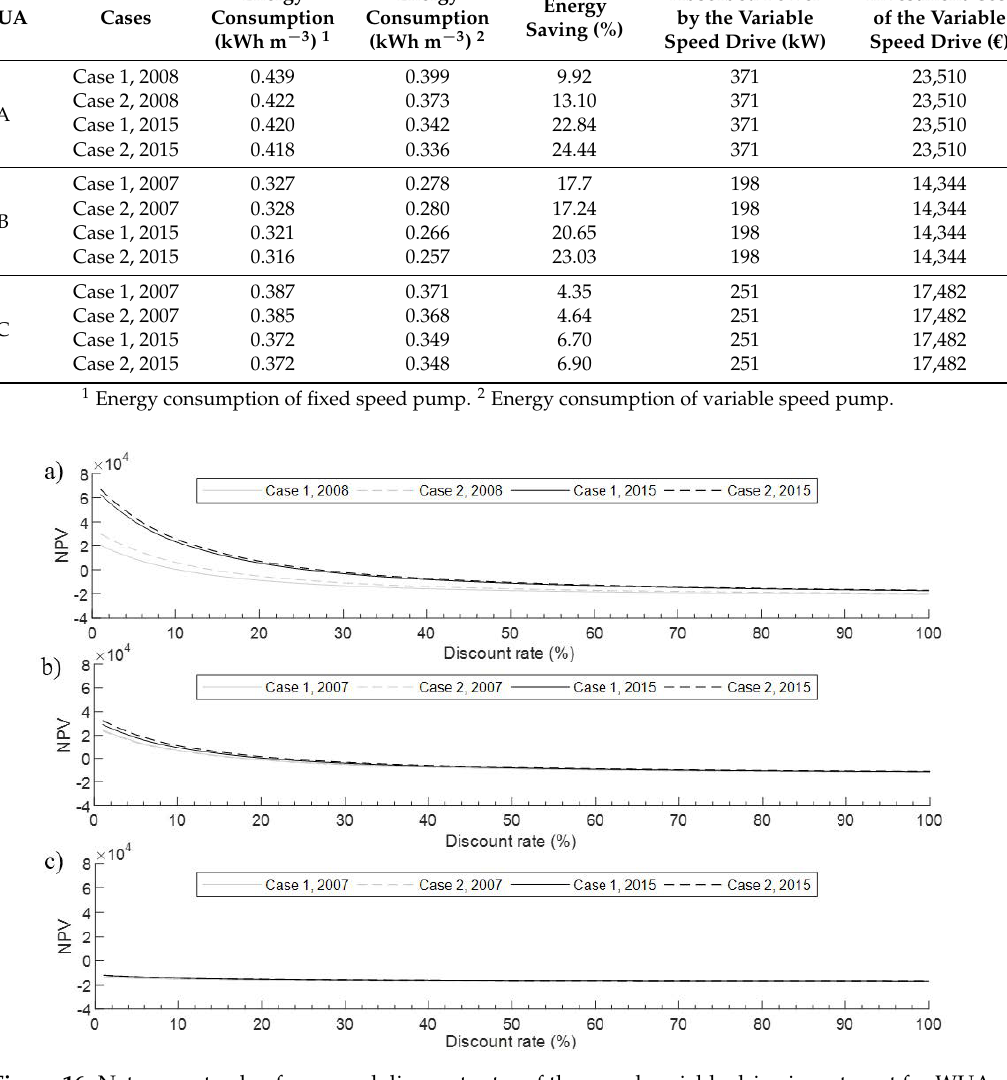
Figure 17. Payback period for several discount rates of the speed variable drive investment for WUA A ( a ) and WUA B ( b ). Regarding the WUA B, in 2007, the IRR values were 18% for Case 1 and Case 2, whereas in 2015, they were 21% (Case 1) and 22% (Case 2). Consequently, although the percentages of energy savings between WUA A and WUA B were similar, the investment safety in WUA B was higher than that of WUA A, and the payback was lower (Figure 17b). These results are because the absorbed power by the variable speed drive in WUA B was much lower than that of WUA A, so the investment cost of b)